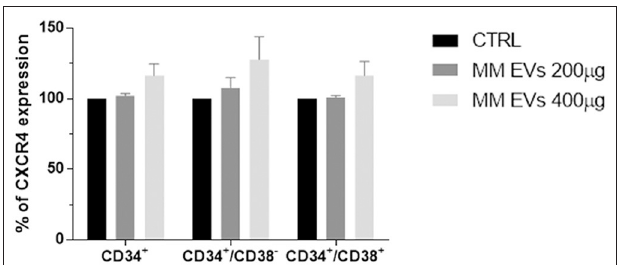
FIGURE 5 | MM-EV effect on CXCR4 expression on HSPCs. Percentage of CXCR4 expression on CD34 + , CD34 + /CD38 − , and CD34 + /CD38 + cells after 20h of treatment with two doses of MM-derived EVs (MM-EVs 200 µ g, MM-EVs 400 µ g). The bar graphs represent the average with standard deviation from three independent experiments. MM, multiple myeloma; EVs, Extracellular vesicles; HSPC, hematopoietic stem and progenitor